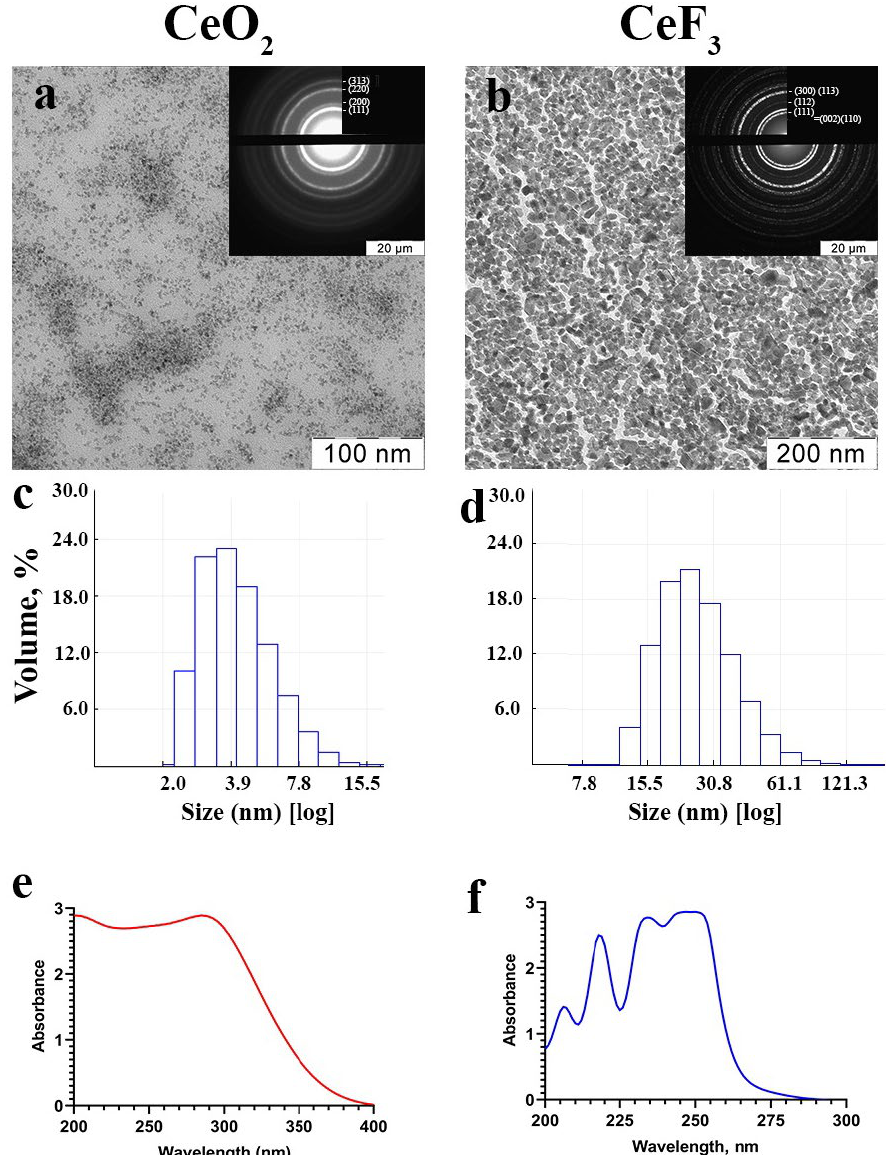
Figure 1. Transmission electron microscopy ( a , b ), dynamic light scattering ( c , d ) in water, and UV absorption spectra ( e , f ) of cerium oxide (CeO 2 ) and cerium fluoride (CeF 3 ) nanoparticles. Insets in ( a , b ) show selected-area electron diffraction data